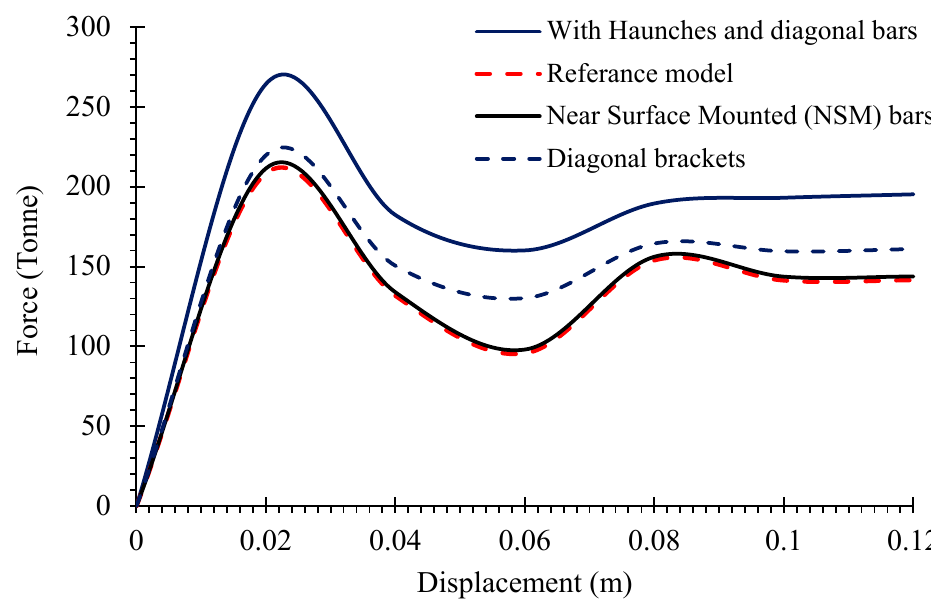
Figure 12. Load vs. displacement curves.